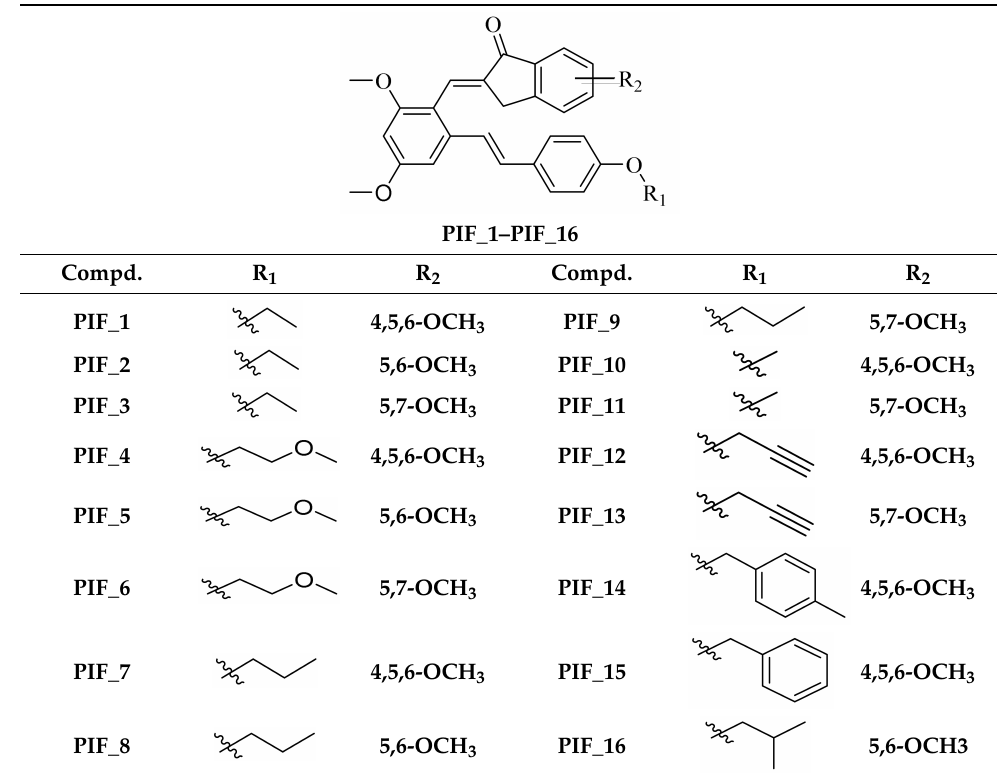
Table 1. Chemical structures of compounds PIF_1–PIF_16